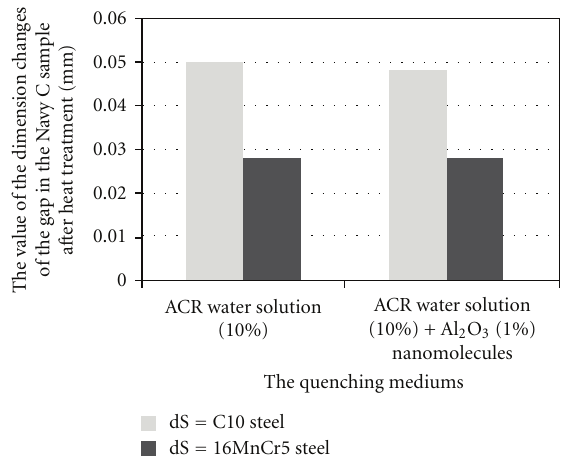
Figure 4: The influence of quenching media on dimension changes of a Navy C-ring sample made of hardened and carburized C10 and 16MnCr5